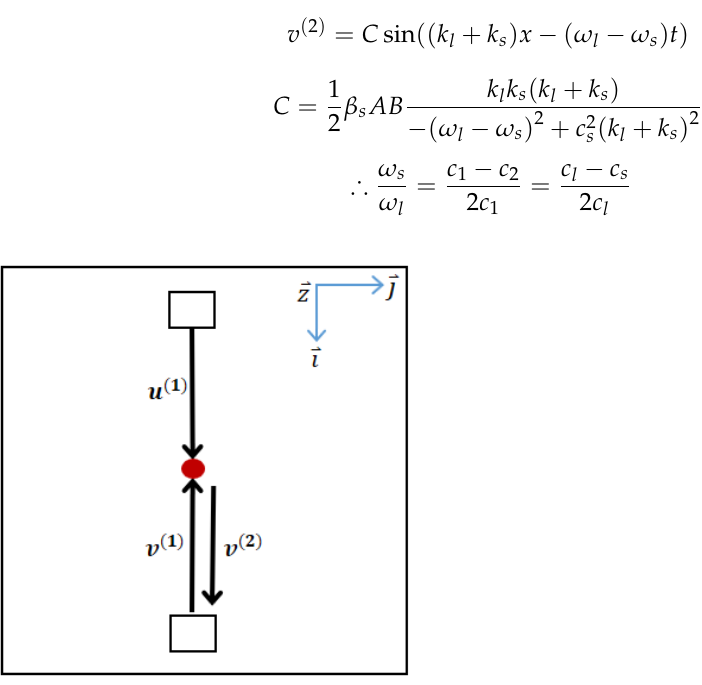
Figure 3. Guided wave mixing concept with mixing signal in a plate.